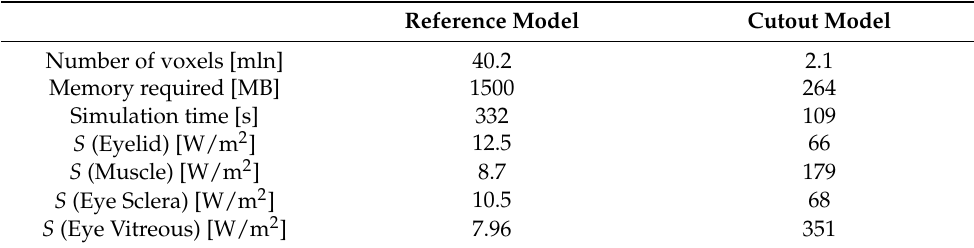
Table 2. The comparison of the reference model and the cutout